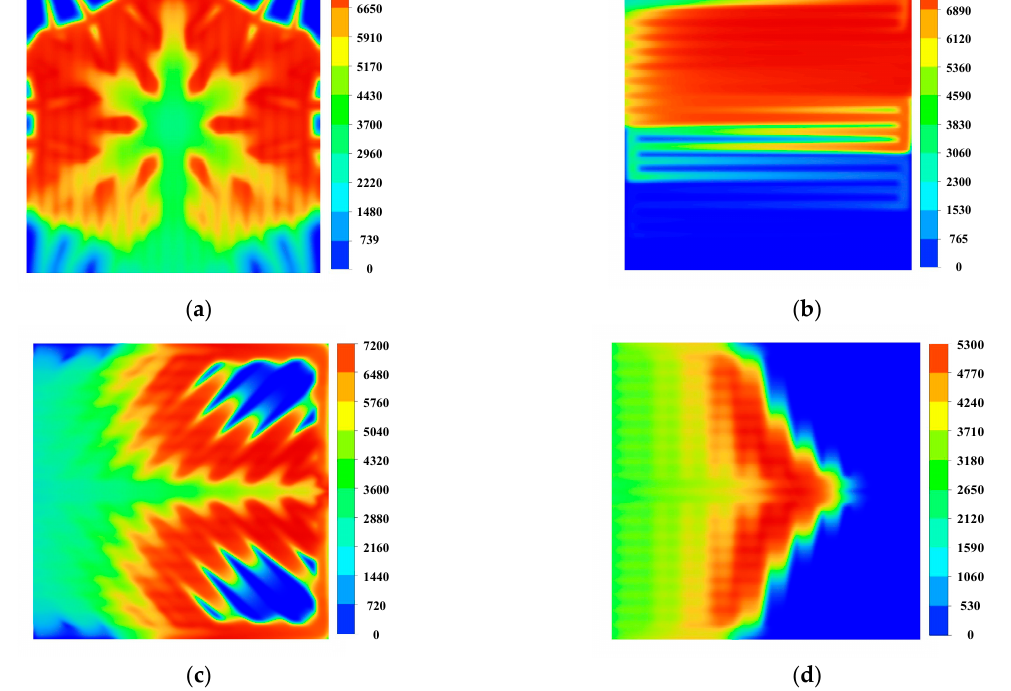
Figure 9. The current density distribution of the membrane (A m − 2 ) (0.8 V): ( a ) Snowflake bionic flow channel; ( b ) dual serpentine flow channel; ( c ) leaf-shape bionic flow channel; ( d ) lung-shape bionic flow channel.